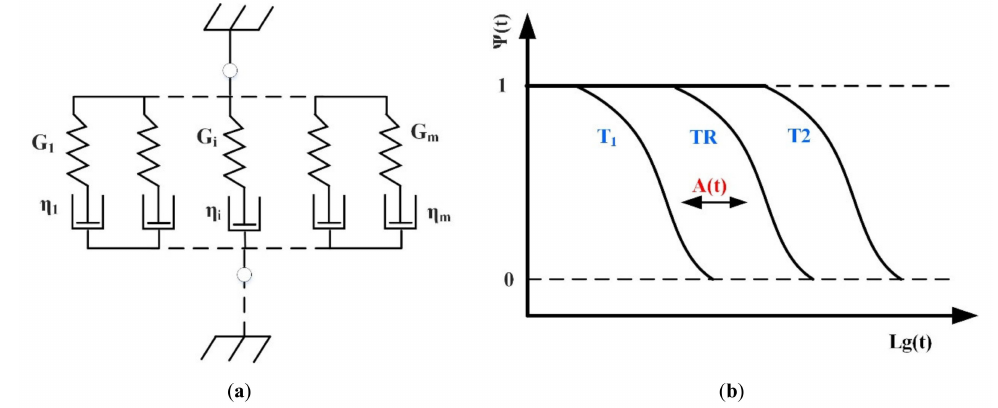
Figure 3. Theoretical model of glass materials. ( a ) Generalized Maxwell model; ( b ) Simple thermos- rheological